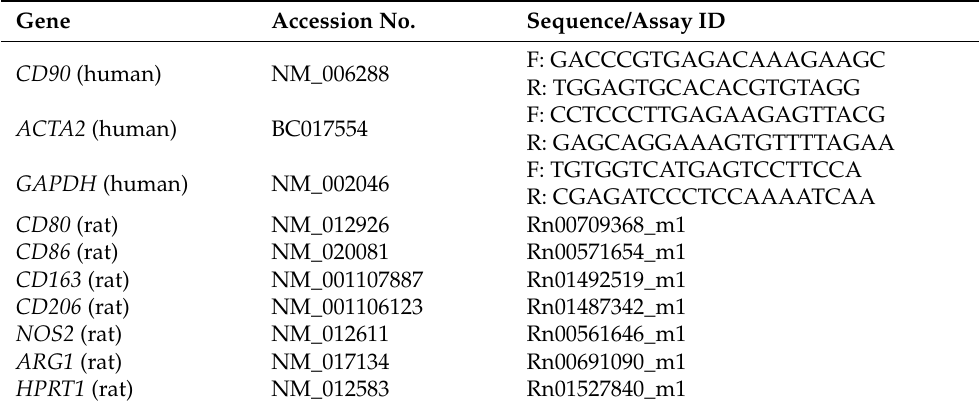
Table 1. Primer sequence used in the RT-PCR analysis. Gene Accession